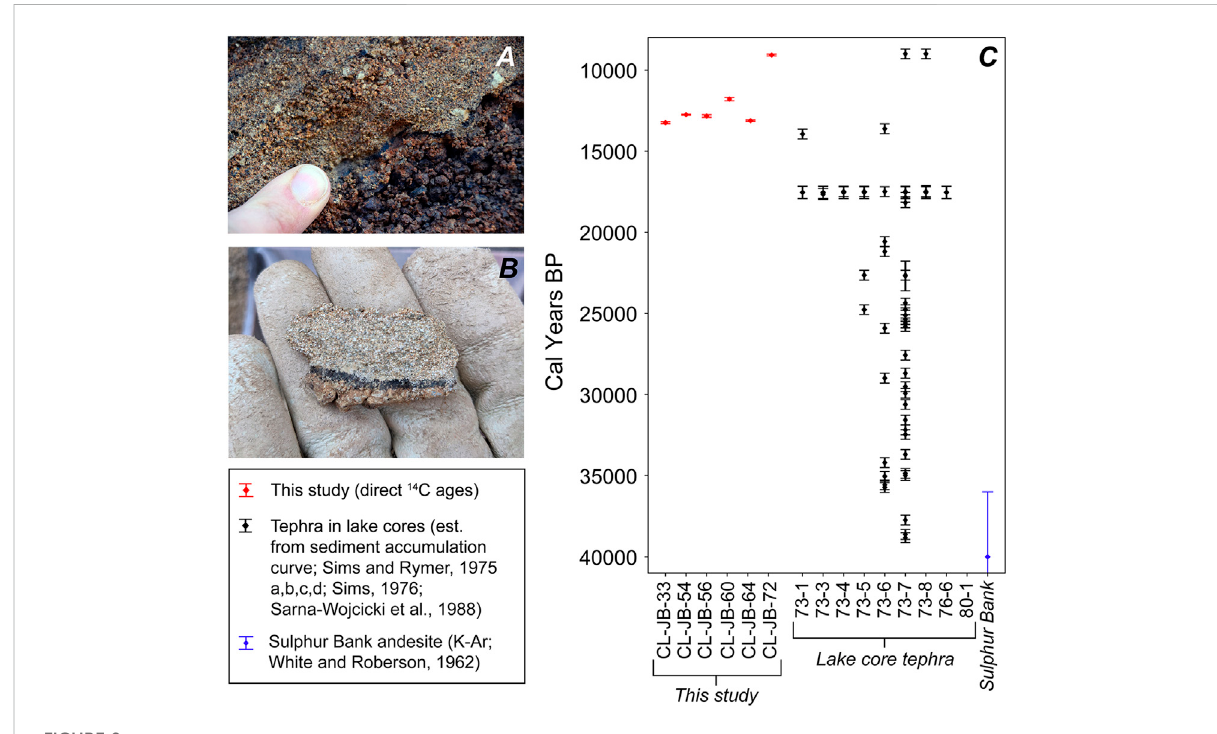
FIGURE 9 Examples of layered carbonized material at S12 (A, B) , as well as the distribution of calibrated radiocarbon dates (C) with error bars indicating 2 σ cal BP ranges. Ages of volcanic ash (tephra) in lake cores as estimated from sediment accumulation curves (Sims and Rymer, 1975c, 1975a, 1975b, 1975d; Sims, 1976; Sarna-Wojcicki et al., 1988) are shown in black, and the K-Ar age of the andesite of Sulphur Bank (one of the youngest dated lava fl ows; White and Roberson, 1962) is shown in blue